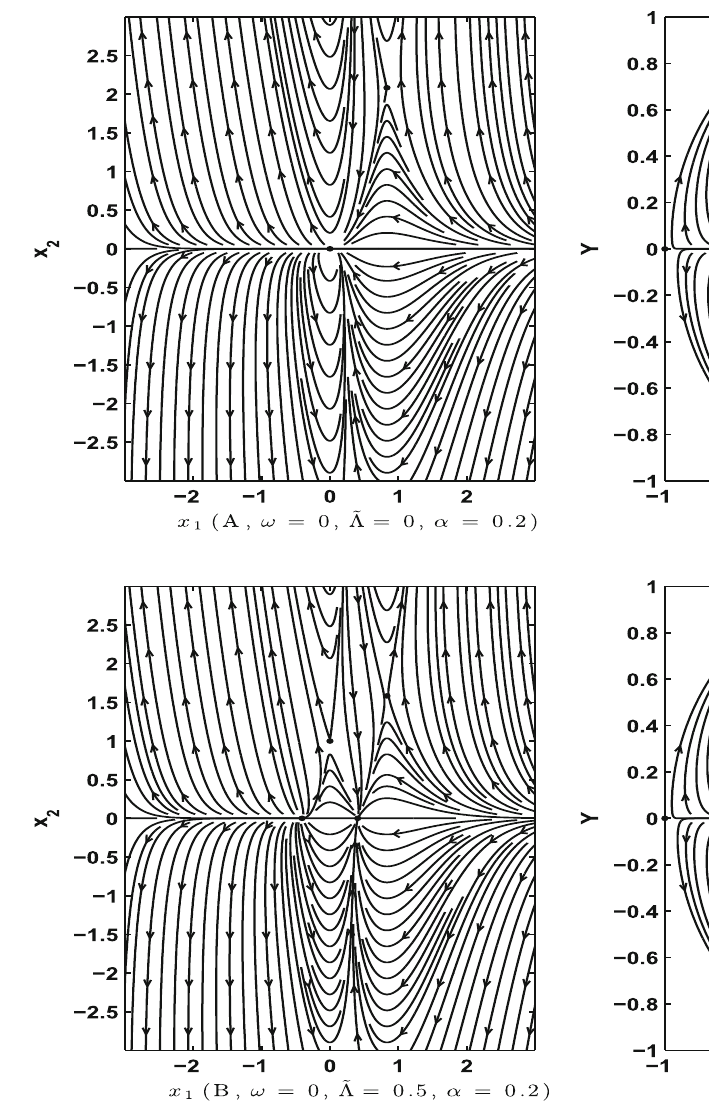
denote the dimensionless ˜ H and ˜ ρ as defined in Eq. (7). X and Y are the coordinates on the Poincaré sphere as defined in Eq. (47). The dotted circles represent fixed